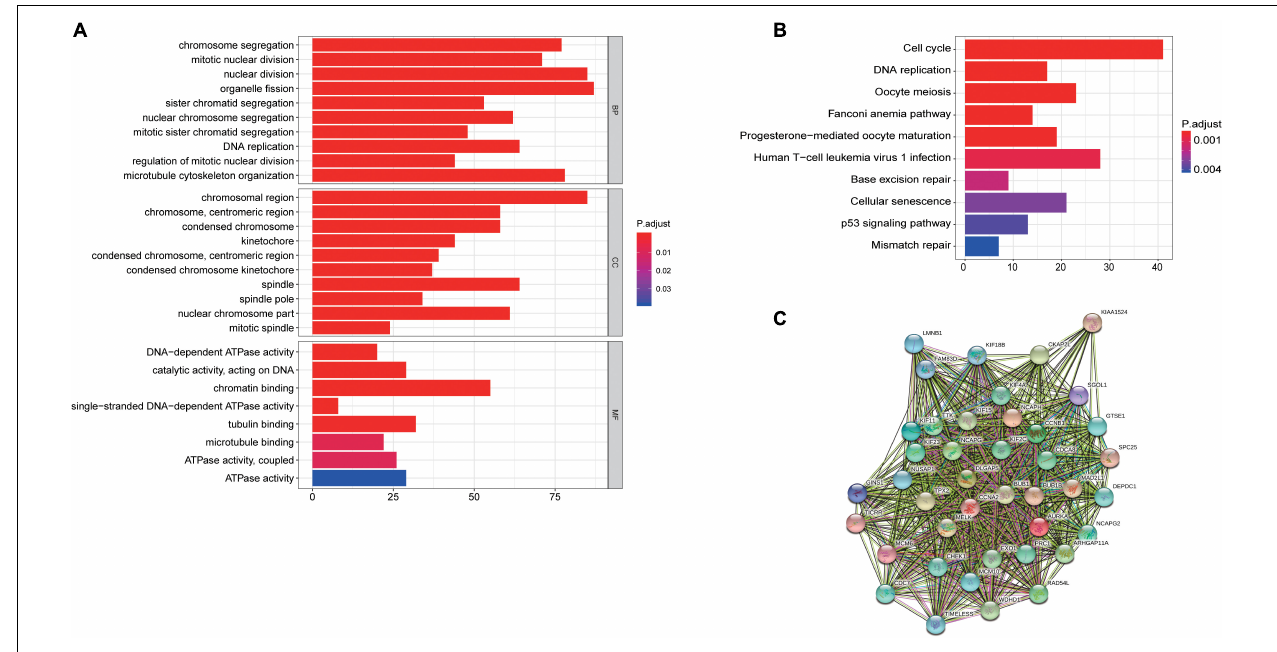
FIGURE 7 | Latent oncogenic mechanisms of RILPL2 in EC. (A) GO analysis of genes in turquoise module eigengenes, top 10 terms were exhibited. (B) KEGG analysis of gene in turquoise module eigengenes, top 10 terms were exhibited. (C) PPIs of hub genes constructed by STRING